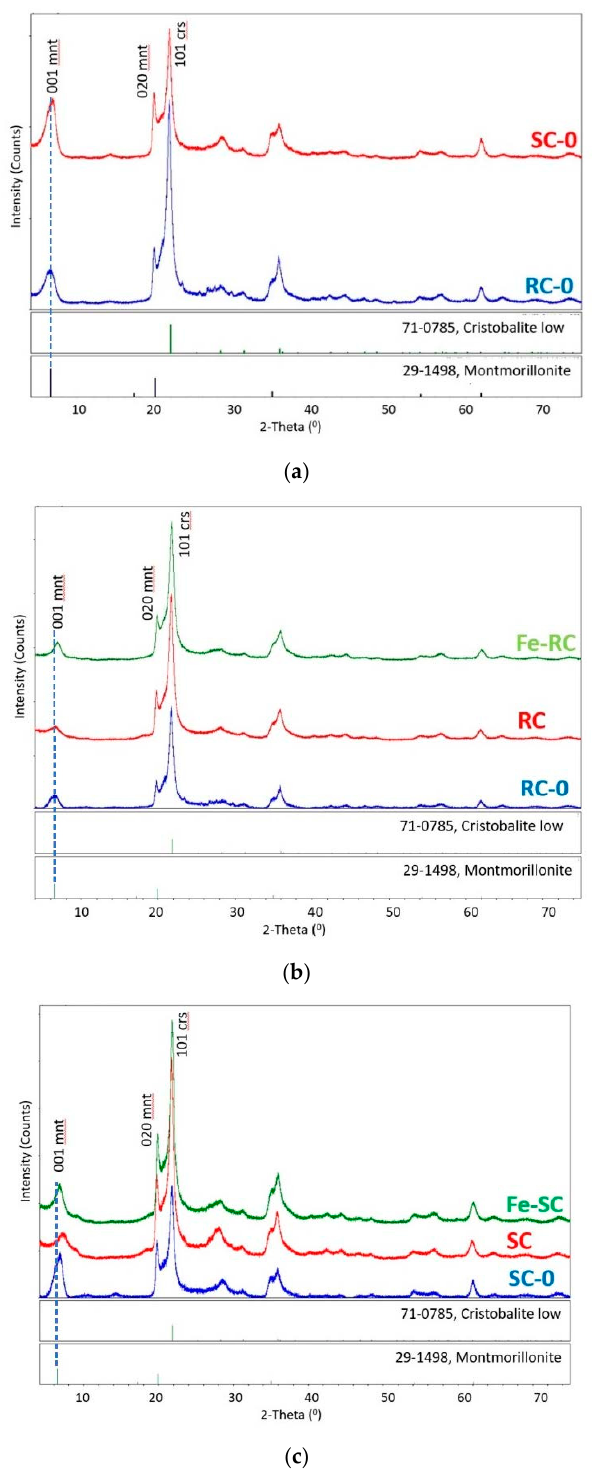
Figure 1. Comparative XRD patterns of ( a ) RC-0 and SC-0; ( b ) RC-0, RC, and Fe-RC; ( c ) SC-0, SC, and Fe-SC clay samples. Legend: mnt = montmorillonite; crs =